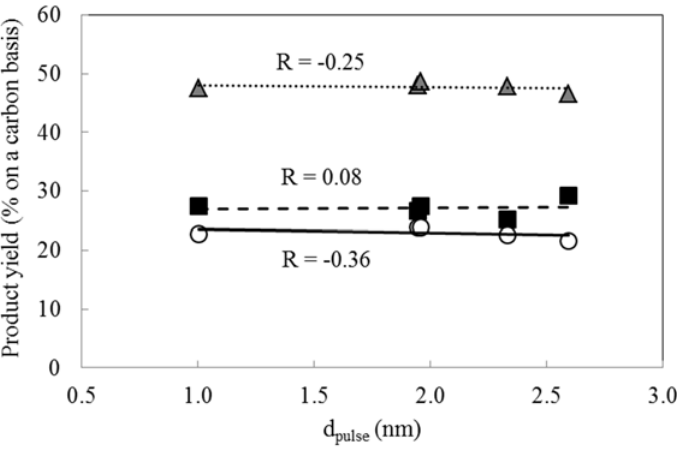
Figure 5. Effect of d pulse on product yield in the hydrocracking reaction over Pt-loaded BEA28 catalysts. Entries 10 and 17–20, Pt content: 0.02 wt. %, ■ Y C1–C8 ; ○ : Y C9–C15 ; ▲ : Y C16+